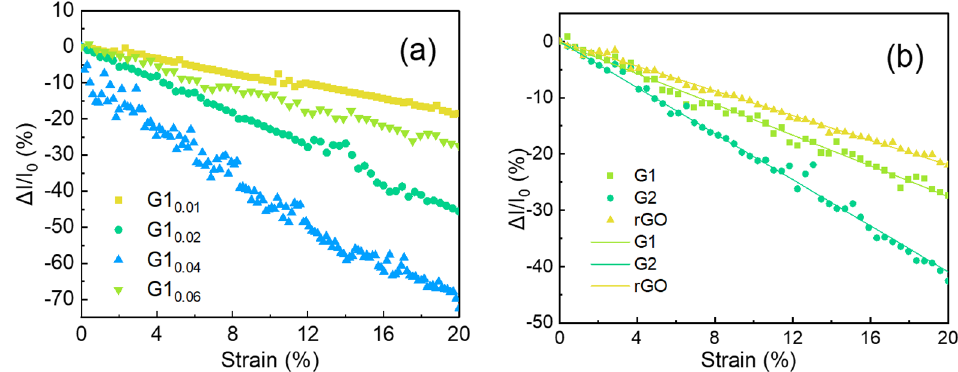
Figure 8. ( a ) Normalized current change Δ I/I 0 plotted as a function of tensile strain (20%) of G1 x - CNT 0.2 /PU composites; ( b ) Δ I/I 0 plotted as a function of tensile strain (20%) of GN 0.06 -CNT 0.2 /PU com- posites.